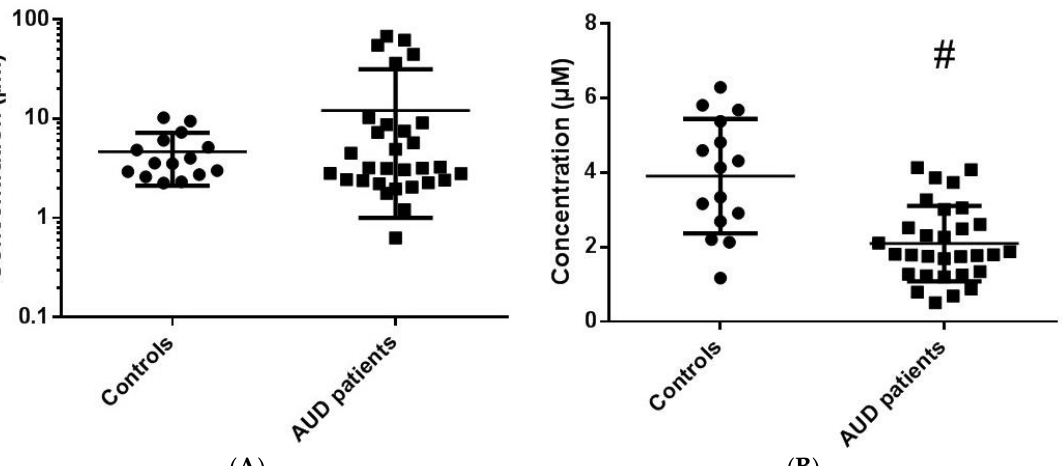
Figure 1. ( A ) TMAO and ( B ) IS concentrations in serum of AUD patients at the treatment entry and in HC. #: p < 0.05 when compared to controls. TMAO: Trimethylamine N -oxide. IS: Indoxyl Sulfate. AUD: Alcohol Use Disorder. HC: Healthy Controls.